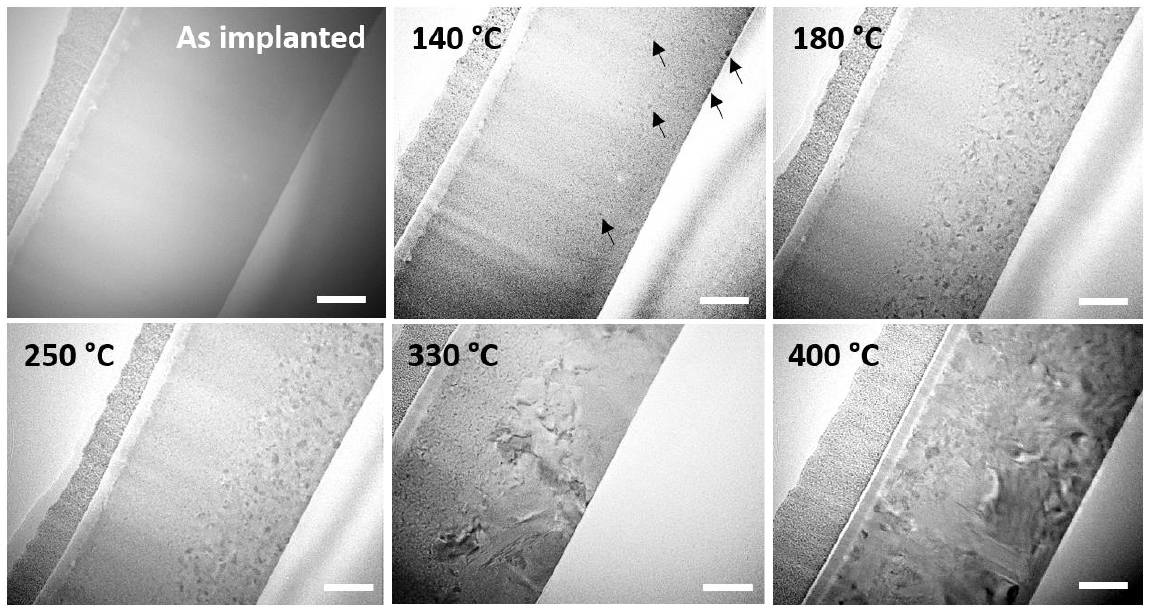
Figure 3. BF TEM micrographs showing the evolution of the structure of the N-implanted GST-225 layer during in situ annealing. The white scale bars refer to a length of 100 nm.